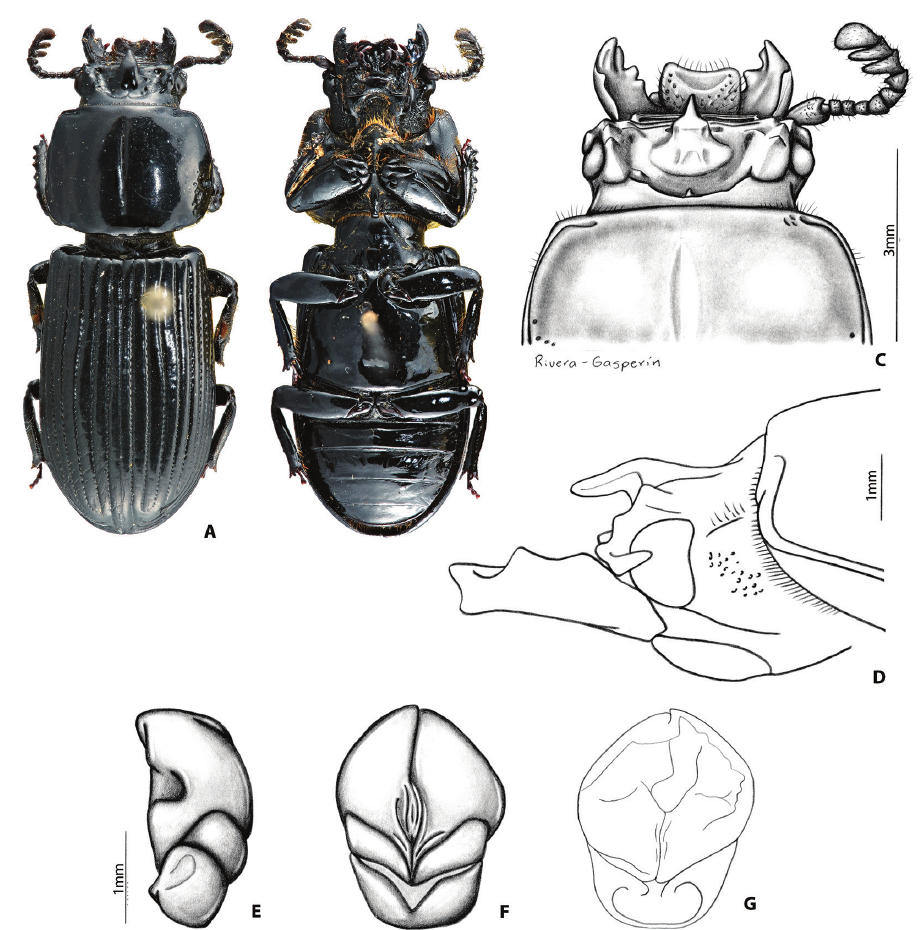
Figure 8. Yumtaax cameliae Beza-Beza, Reyes-Castillo & Jameson, sp. n., holotype: A dorsal habitus B ven- tral habitus C dorsal view of pronotum and head D lateral view of pronotum and head E lateral view of aedeagus F ventral view of aedeagus G dorsal view of